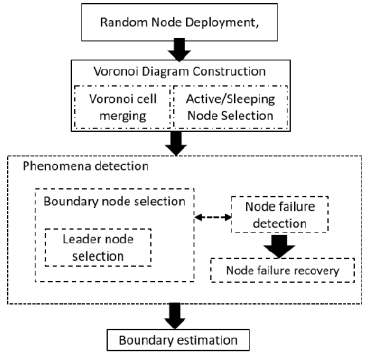
Figure 1. Overview of the proposed work.